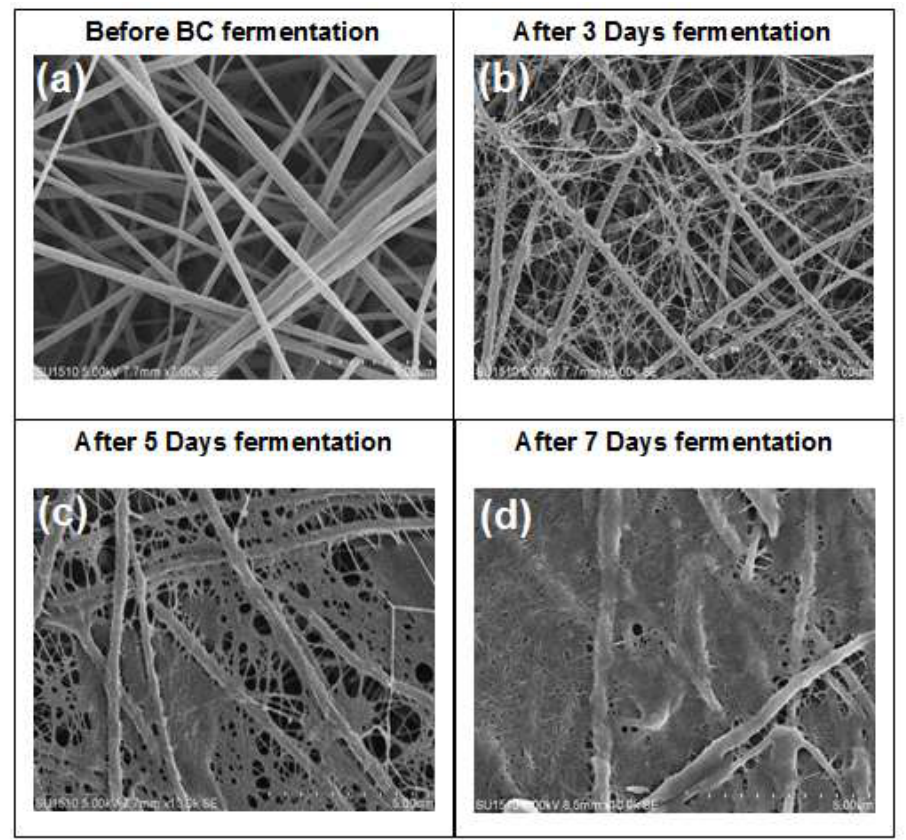
Figure 3. SEM images for BC/CA-ENM hybrid mats; surface morphology: ( a ) before fermentation; ( b ) after three days of fermentation; ( c ) after five days; and ( d ) after seven days.